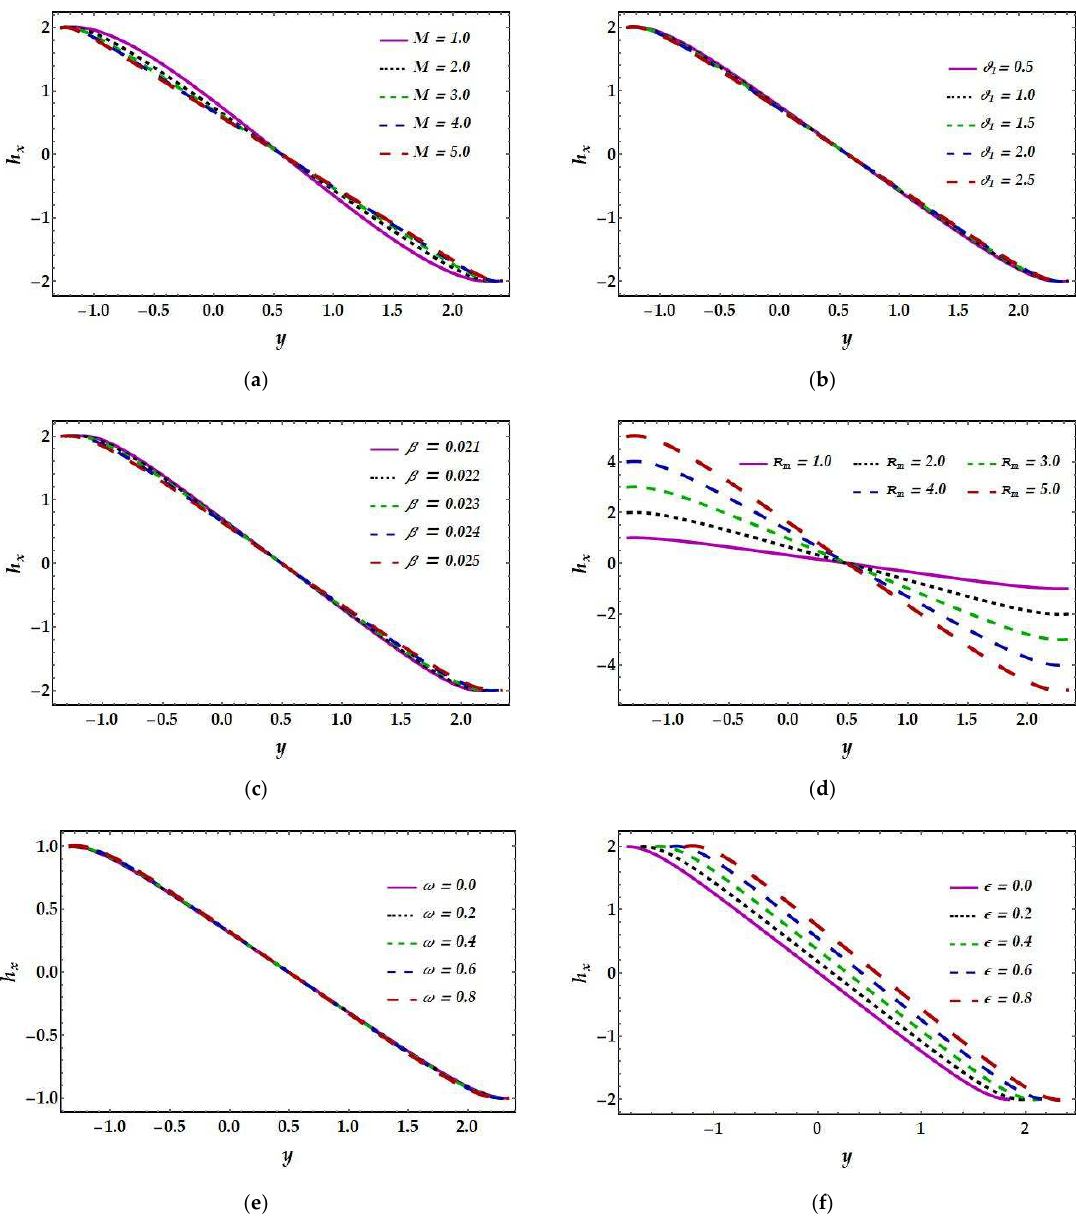
Figure 4. Effects of different physical parameters on induced magnetic fields h x 4.4. Current Density